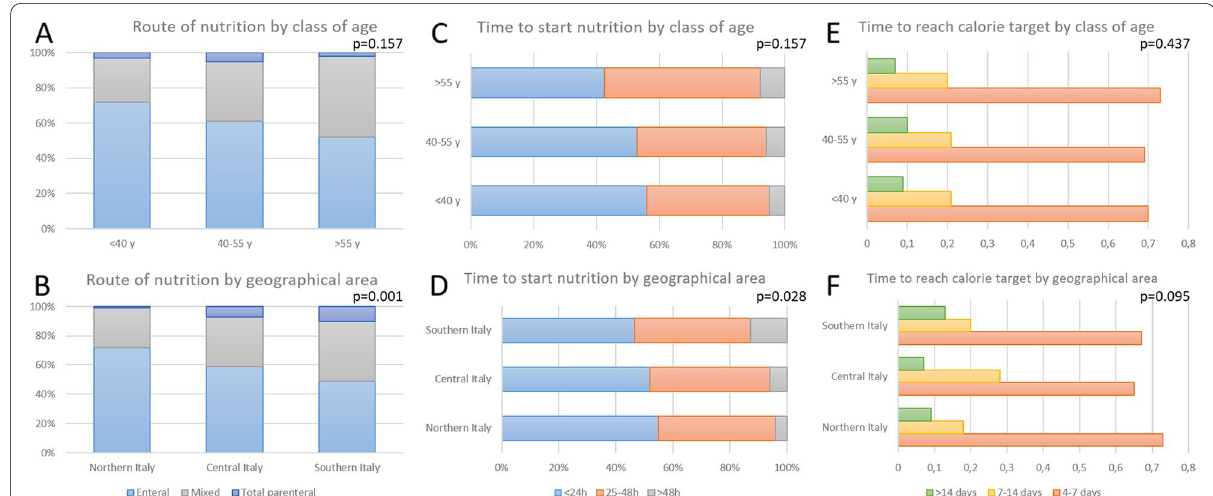
Fig. 2 Relationship between the route of nutrition (left panel), time to start the support (middle panel), and time to reach the target (right panel) and the class of age (upper) and geographical area (lower) of the respondents